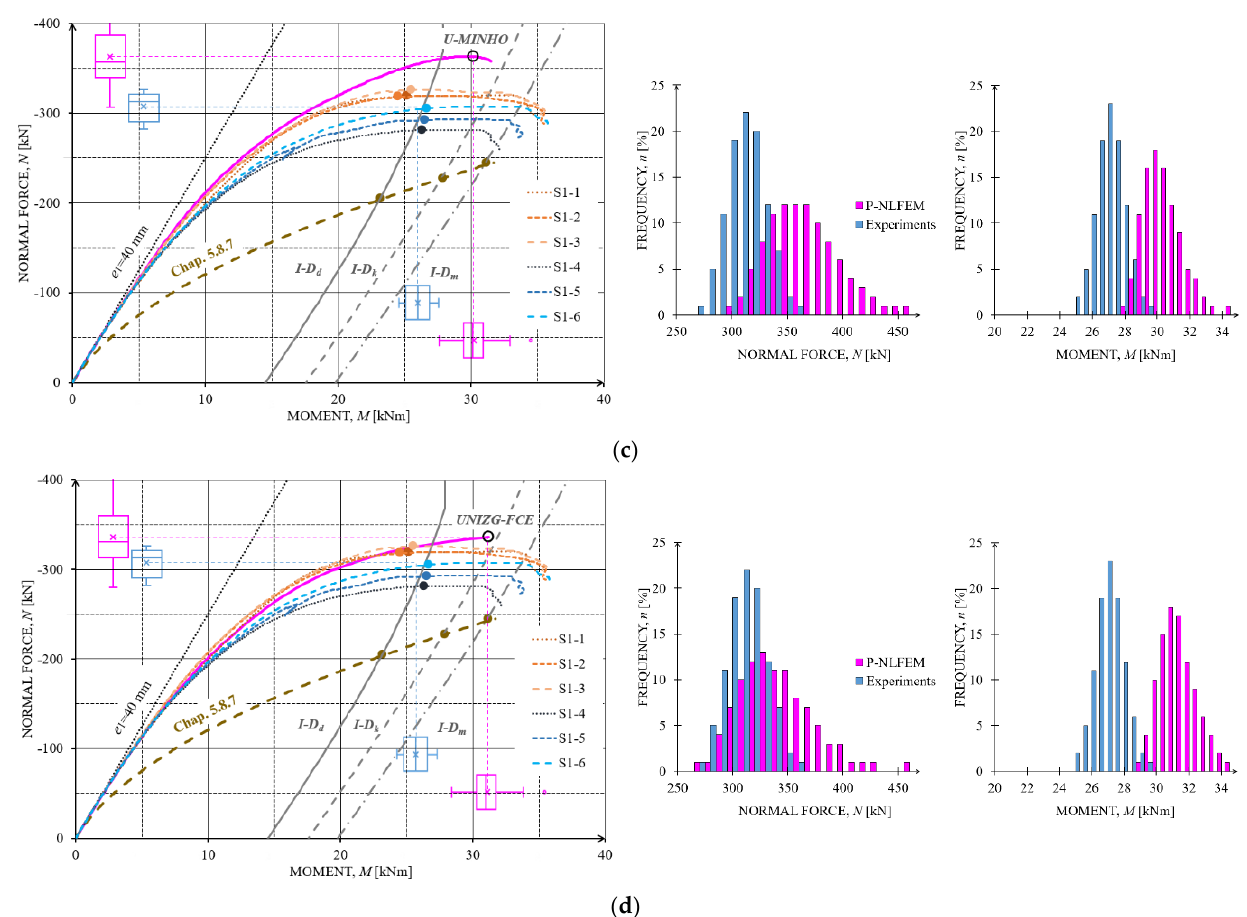
Figure 12. Statistical structural responses and PDFs obtained according to EN1992-1 non-linear finite element analyses: ( a )